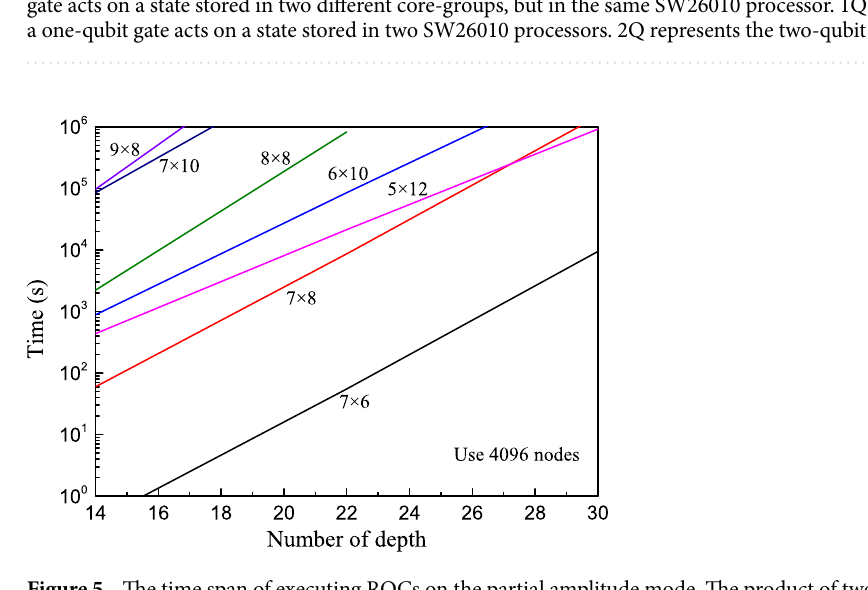
Fig. 7. It consists of three main stages, i.e., phase estimation, controlled rotation and uncomputation. The com- plexity of our algorithm is O